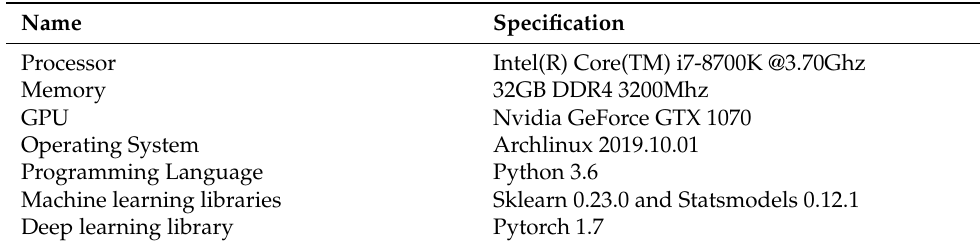
Table 5. List of software and hardware used in the